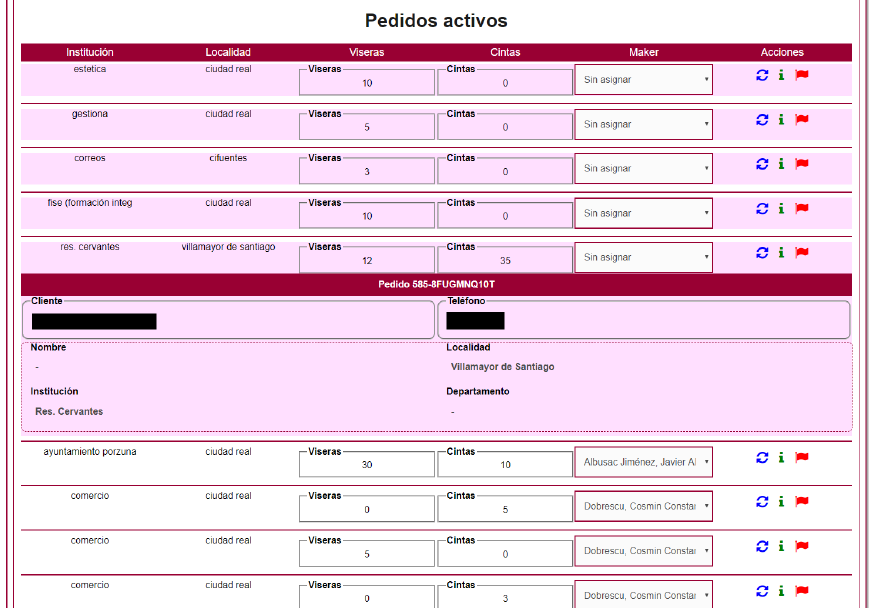
Figure 8. Listing of products in the manufacturing process. Access to the product detail. Monitoring of the status of each